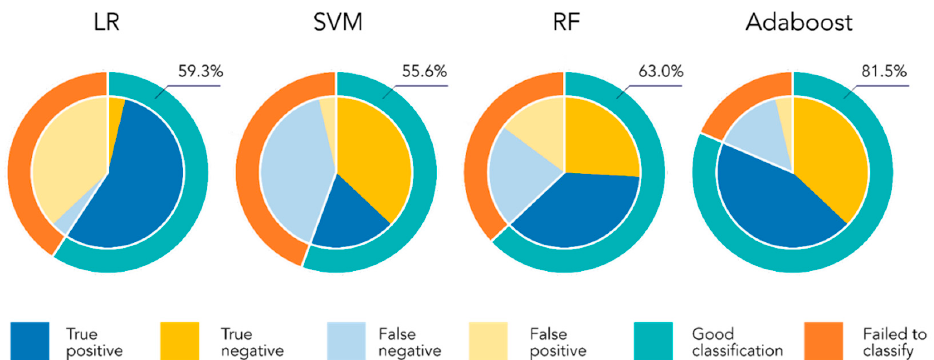
Figure 1. Classification results of the different algorithms on the EGFR amplification detection tasks. The external circle of each plot shows the success/failure of each AI. The reported value is the obtained accuracy, that is, the percentage of success. The inside pie presents the 2 classes distribution: the light colors show the proportion of data of each class that are not correctly classified by the algorithm.